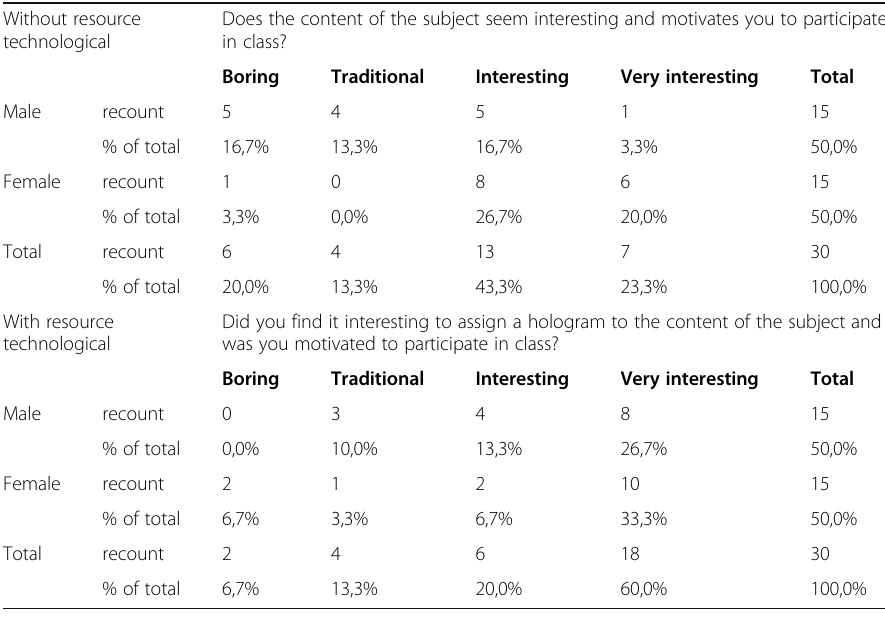
Table 5 Comparative pre and post- questionnaire about interest and motivation in the classroom. Cross